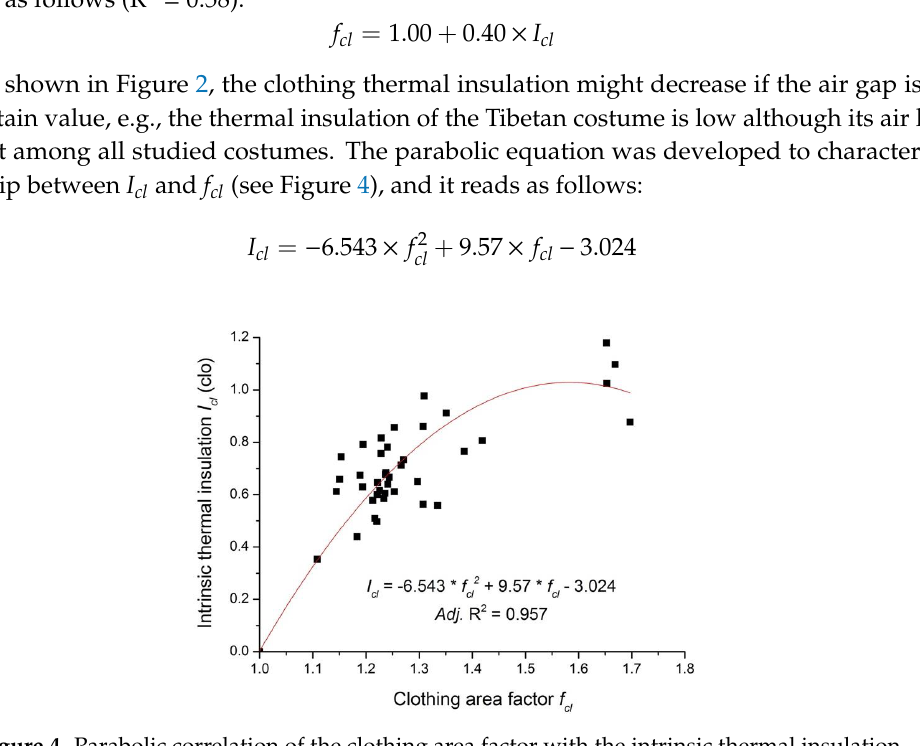
Figure 3. Relationship between the clothing intrinsic thermal insulation and the clothing area factor.